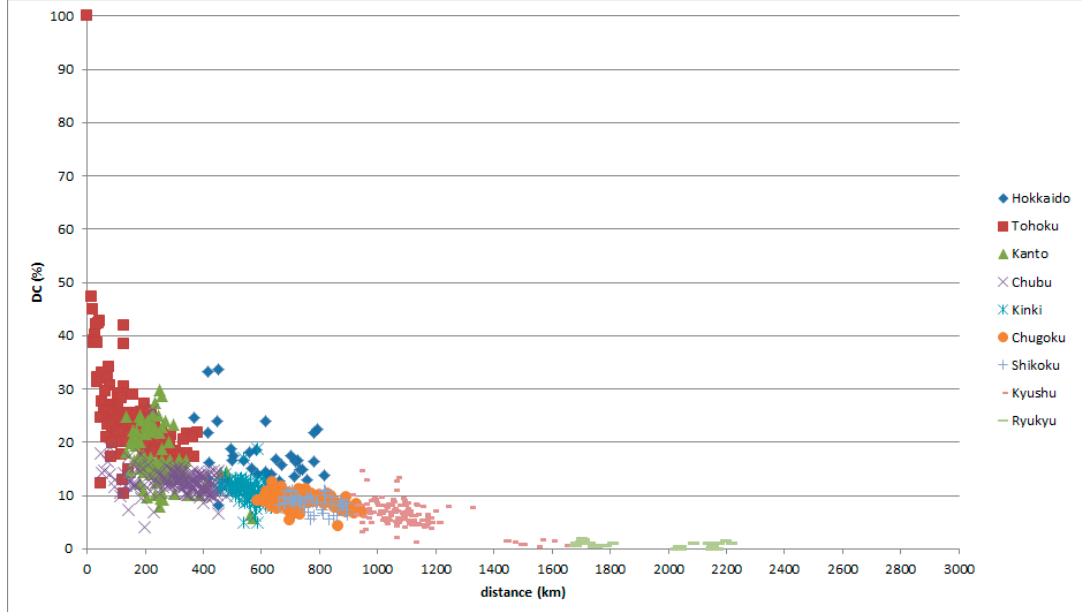
Figure 15. GAJ data with reference place in Tohoku, classified by comparison place.